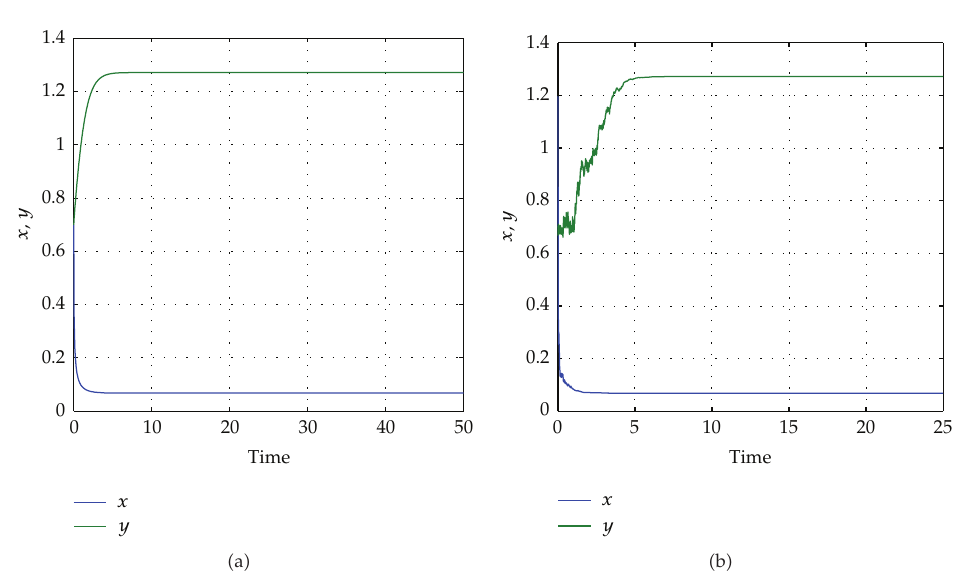
Figure 4: The solution of the stochastic model (cid:4) 3.2 (cid:5) . The parameters are taken as a (cid:6) 2 , b (cid:6) 0 . 25 , c (cid:6) 0 . 875 , e (cid:6) 1 , m (cid:6) 0 . 95 , n (cid:6) 0 . 9 , and f (cid:6) 0 . 8. (cid:4) a (cid:5) α (cid:6) β (cid:6) 0; (cid:4) b (cid:5) α (cid:6) 0 . 8 and β (cid:6) 0 . 4.